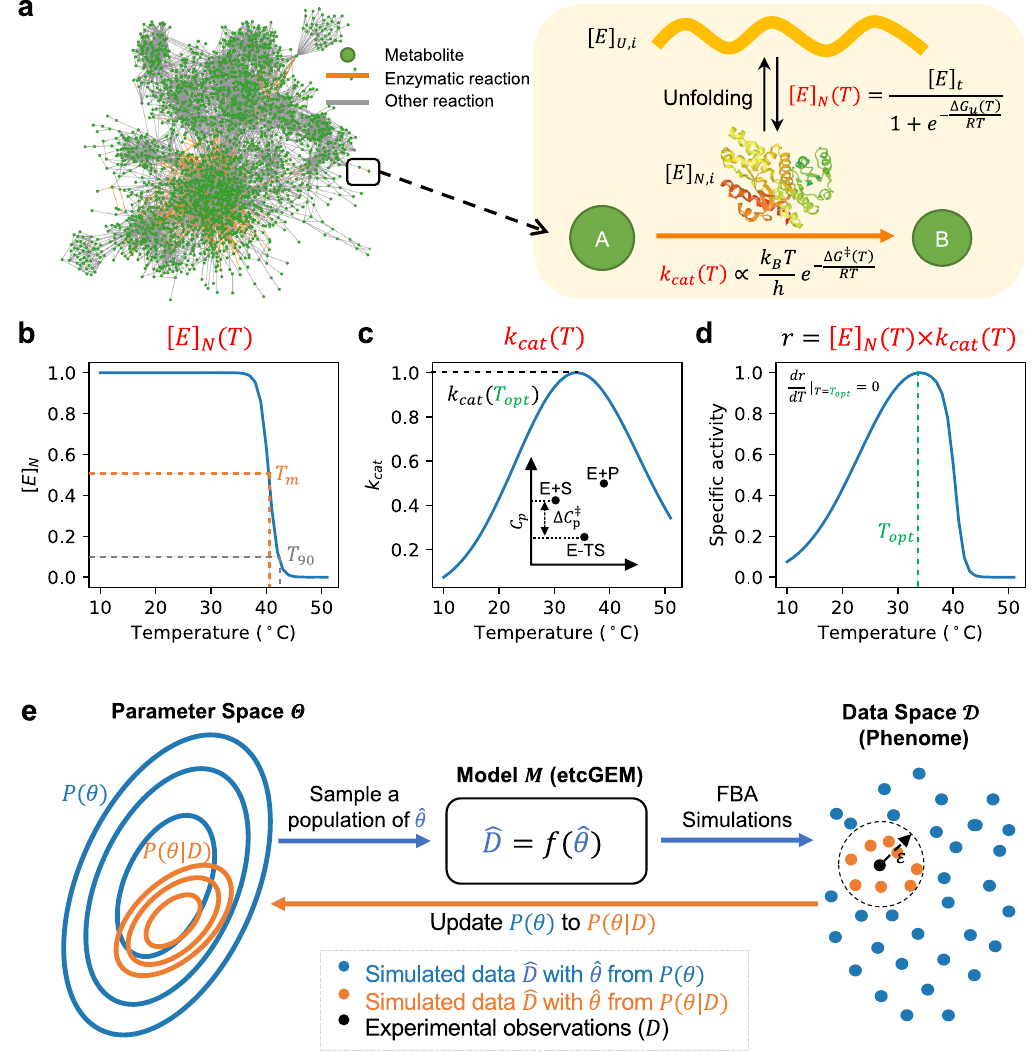
Fig. 1 Using Bayesian statistical learning to integrate temperature dependence in enzyme-constrained GEMs. a An illustration of the temperature effects on enzyme-catalyzed reactions and their integration into an etcGEM (see detailed description and equations in “ Methods ” section). The metabolic network ecYeast7.6 16 is shown. b A two-state denaturation model 20,21,58 was used to describe the temperature-dependent unfolding process. [ E ] N is the concentration of the enzyme in the native state; T opt is the optimal temperature at which the speci fi c activity is maximized; T m and T 90 are temperatures at which there is a 50 and 90% probability that an enzyme is in the denatured state, respectively. c Macromolecular rate theory 31,33 describing the temperature dependence of enzyme turnover number k cat . Inset shows the heat capacity difference between ground state (E + S) and transition state (E − TS), adapted from Hobbs et al. 31 . d Temperature dependence of enzyme- speci fi c activity r , which is a product of ( b ) and ( c ). e Overview the Bayesian statistical learning approach, where the problem can be formulated as given a generative model (M) (enzyme and temperature constrained genome-scale metabolic model, etcGEM in this study) corresponding to a set of parameters θ and a set of measurements D (phenome data), Bayes ’ theorem provides a direct way of updating the Prior distribution of parameters P ( θ ) to a Posterior distribution P ( θ | D ): P ð θ j D Þ ¼ P ð D j θ Þ ´ P ð θ Þ . P ( θ |D ) is thereby a less uncertain P ð D Þ description of the real θ . Since P ( D | θ ) is, in most applications, computationally expensive or even infeasible to obtain, a sequential Monte Carlo based approximate Bayesian computation (SMC-ABC) approach was implemented ( “ Methods ” ) to sample a list of parameter sets from the Posterior